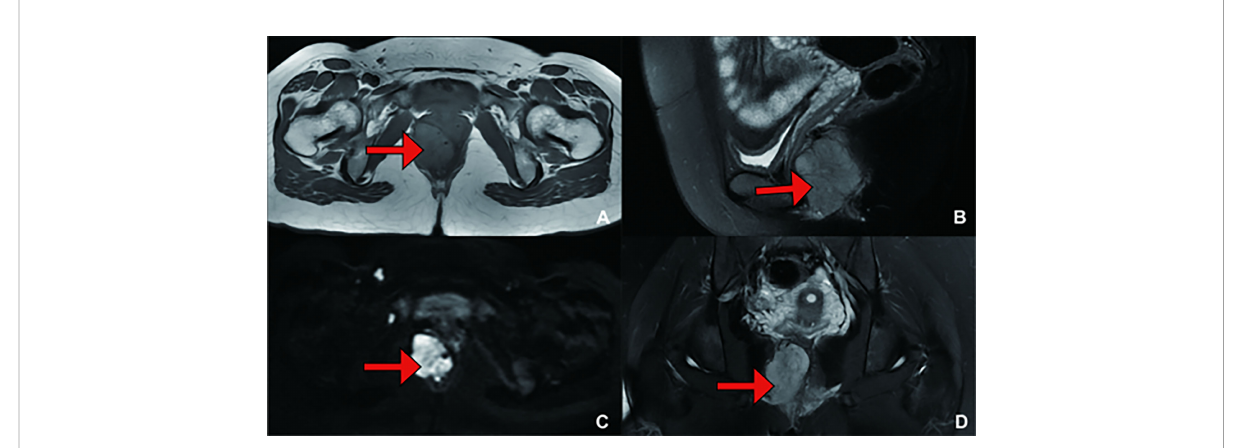
FIGURE 3 (Recurrence Treatment) Pelvic MRI showing a mass measuring 4.3 cm*3.6 cm*5.4 cm in size, suggesting that the lesion was closely related to the right posterior vaginal wall and anterior rectal wall. (A) T1 weighted imaging (T1WI); (B) T2 weighted imaging (T2WI); (C) Diffusion Weighted Imaging (DWI); (D) T2 weighted imaging